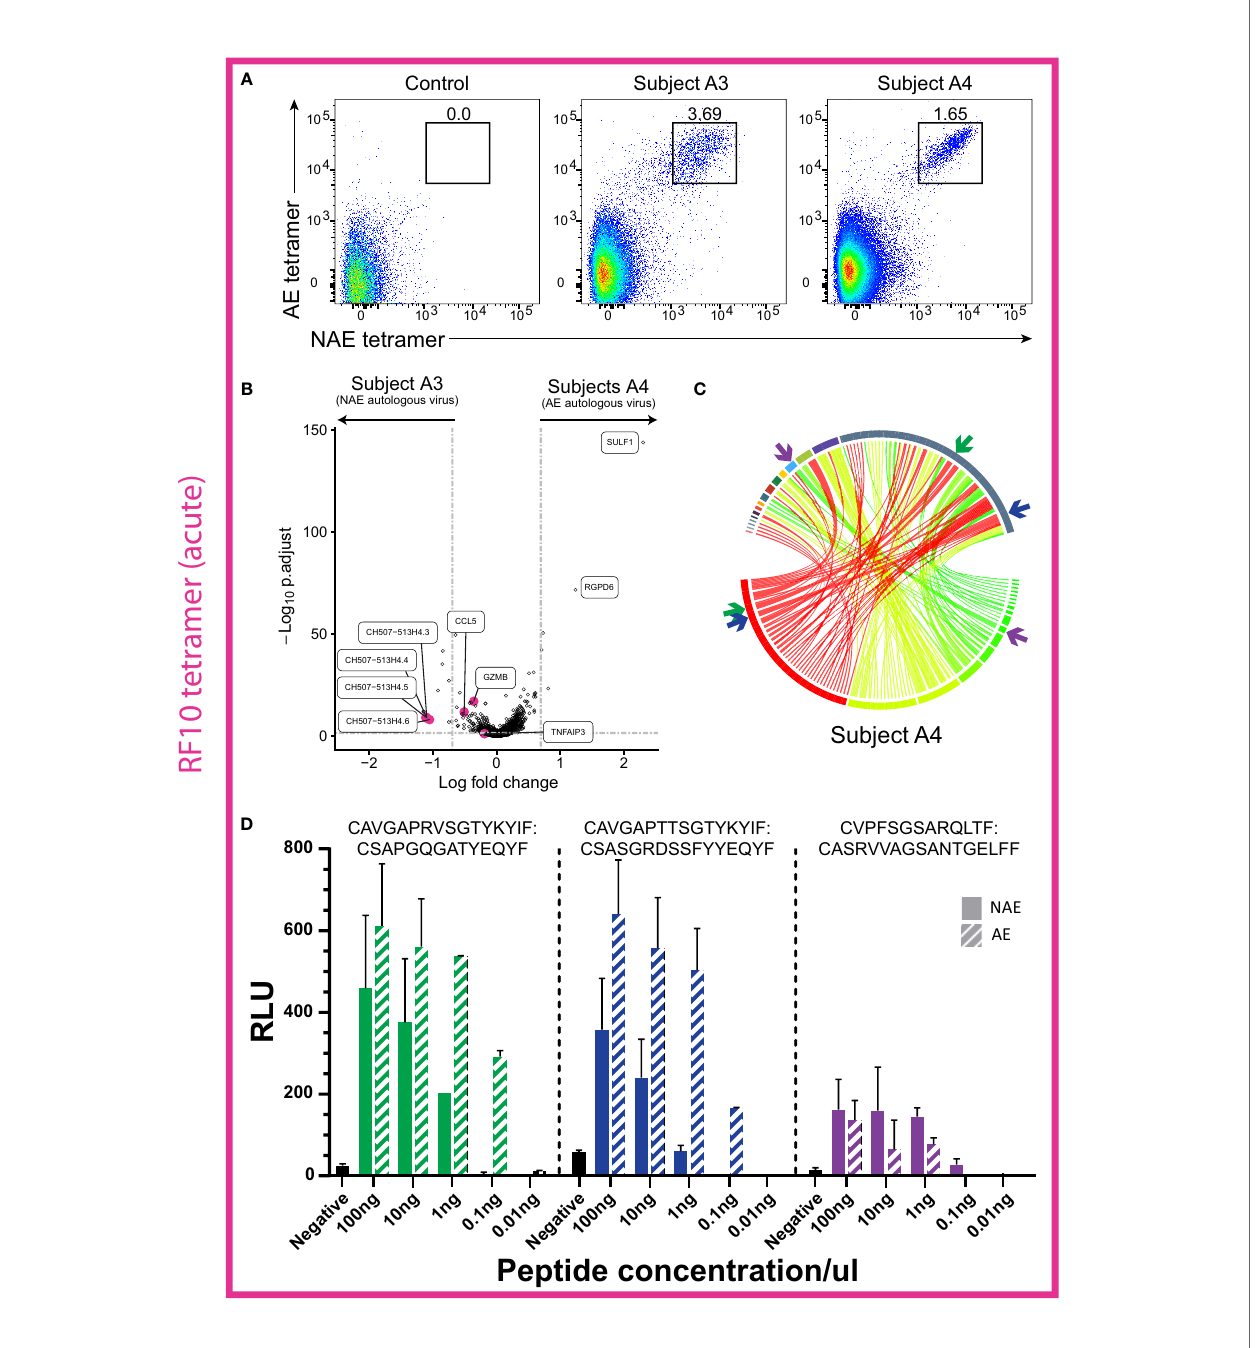
FIGURE 5 | Cross-reactive CD8 + T cells in two acute HIV-infected individuals showed little difference in transcriptome pro fi les, but TCRs from one subject revealed a higher antigen-speci fi c reactivity to the AE form of RF10. (A) Flow cytometry plots in acute HIV-infected subjects A3 and A4 reveal a distinct cross-reactive (dual tetramer + ) CD8 + T cell population for the epitope RF10. (B) Volcano plot for resting cross-reactive (dual tetramer + ) memory RF10-speci fi c CD8 + T cells for subjects A3 and A4 revealed few signi fi cant DEGs (N = 2). Horizontal and vertical dotted lines represent a signi fi cant threshold of a FDR of 0.05 and a fold change of |2|, respectively. (C) Circos plot reveals no dominant TCR a / b combination in subject A4, but rather a high diversity of TCRs (N = 1). TCR a / b combinations are colored as a heatmap. b chains are depicted on the bottom, with a chains depicted on the top. The width of each band correlates with the frequency of the respective a / b combination. (D) Two of the three TCR a / b combinations tested in a TCR reporter assay showed higher antigen speci fi c reactivity to the AE form of RF10 (subject A4; N = 1). The combinations tested are highlighted with colored arrows in panel (B) The negative control is transfected Jurkat cells with antigen presenting cells minus peptide. RLU = relative light units. Note that RLU values cannot be compared across TCRs due to variability in plasmid transfection rates (see Materials and Methods for more